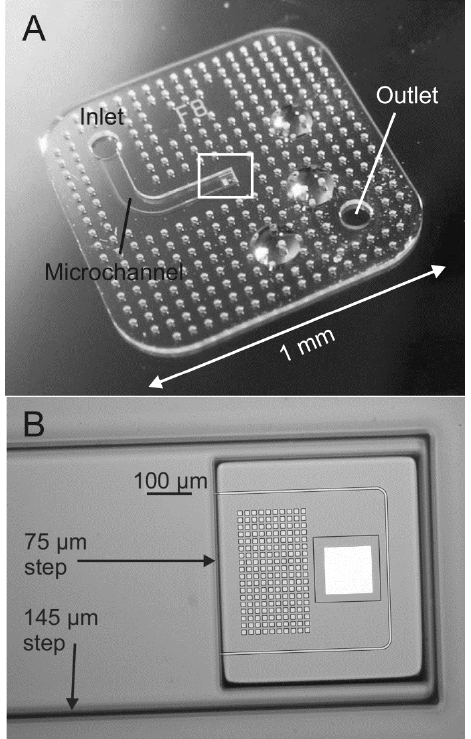
Figure 3. ( a ) SU-8 microchip with microfluidic channel; ( b ) top view of a 3.7 µm thick SU-8 flow sensor containing 180 holes with dimensions 10 × 10 µm 2